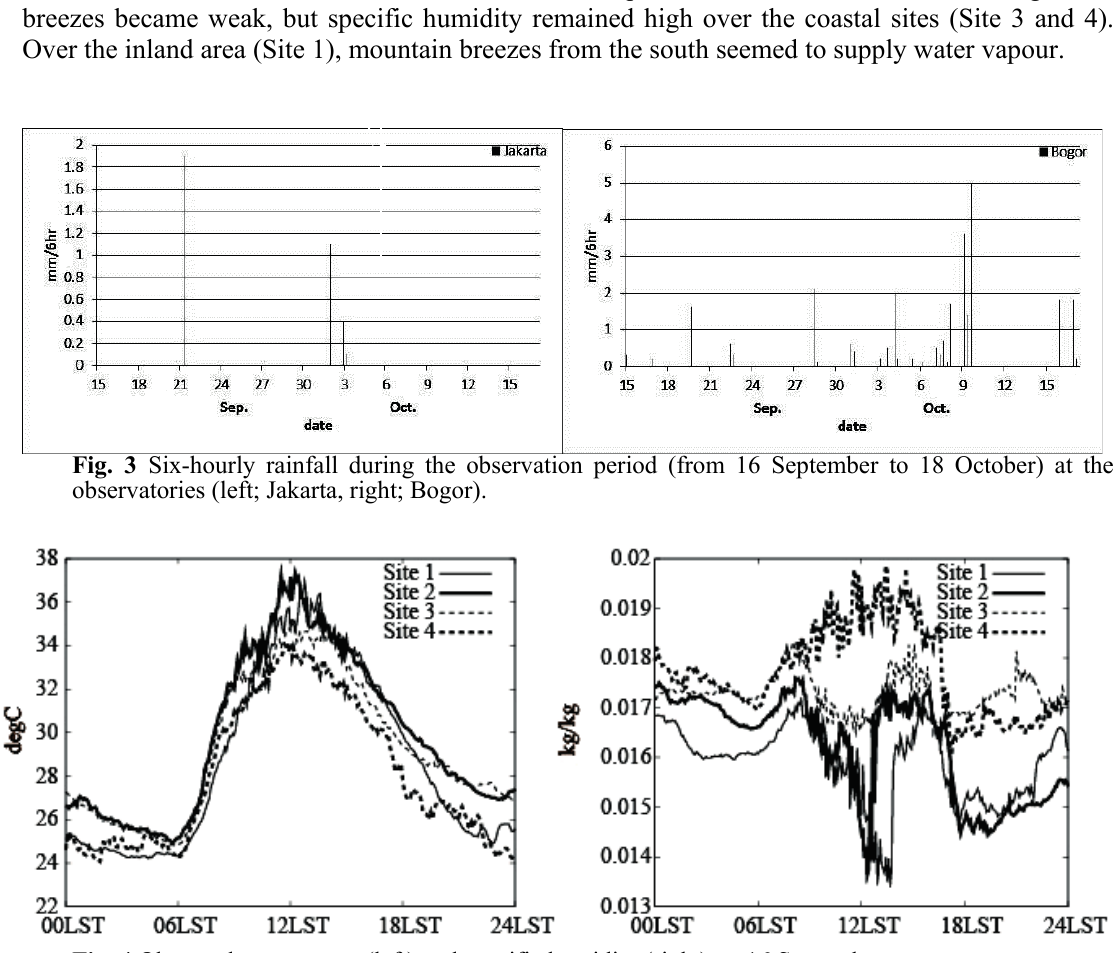
Fig. 4 Observed temperature (left) and specific humidity (right) on 16 September.